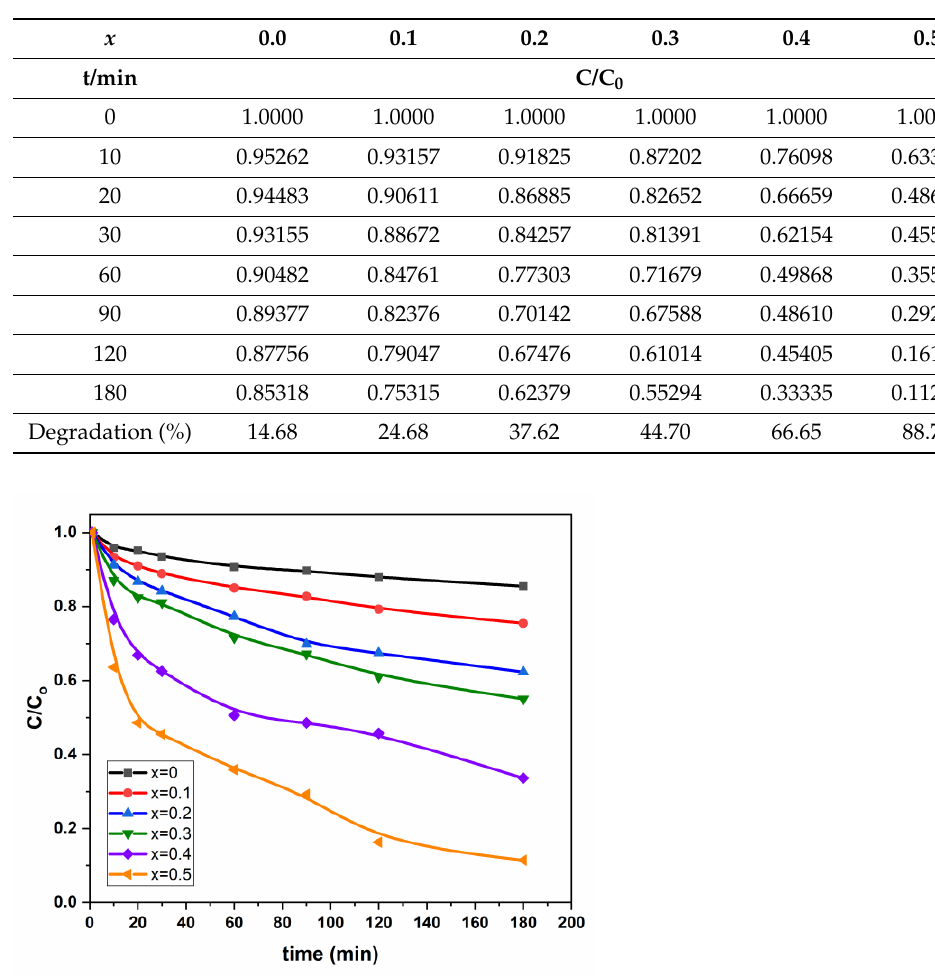
Table 2. C/C 0 and Pen G degradation onto (Mn 0.5 Zn 0.5 )[Cd x Fe 2- x ]O 4 (x ≤ 0.05) NSFs.